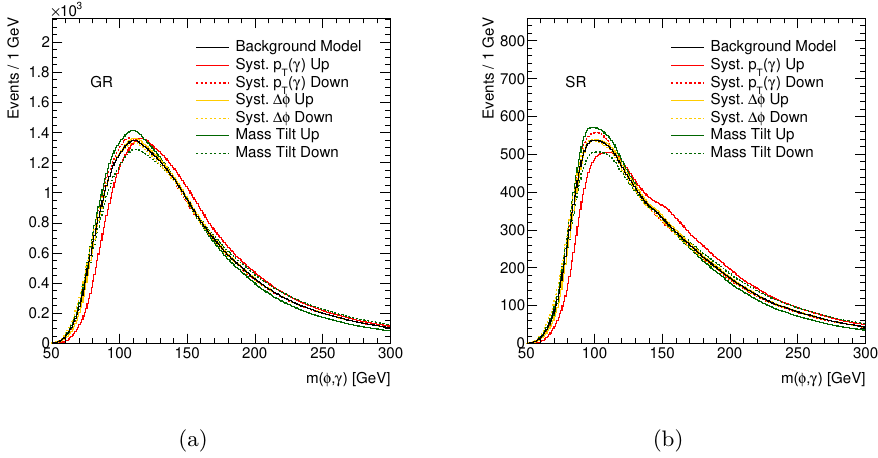
Figure 6 . Comparison of the m ( φ, γ ) distributions for the GR (left) and SR (right) associated with the three pairs of systematic shape